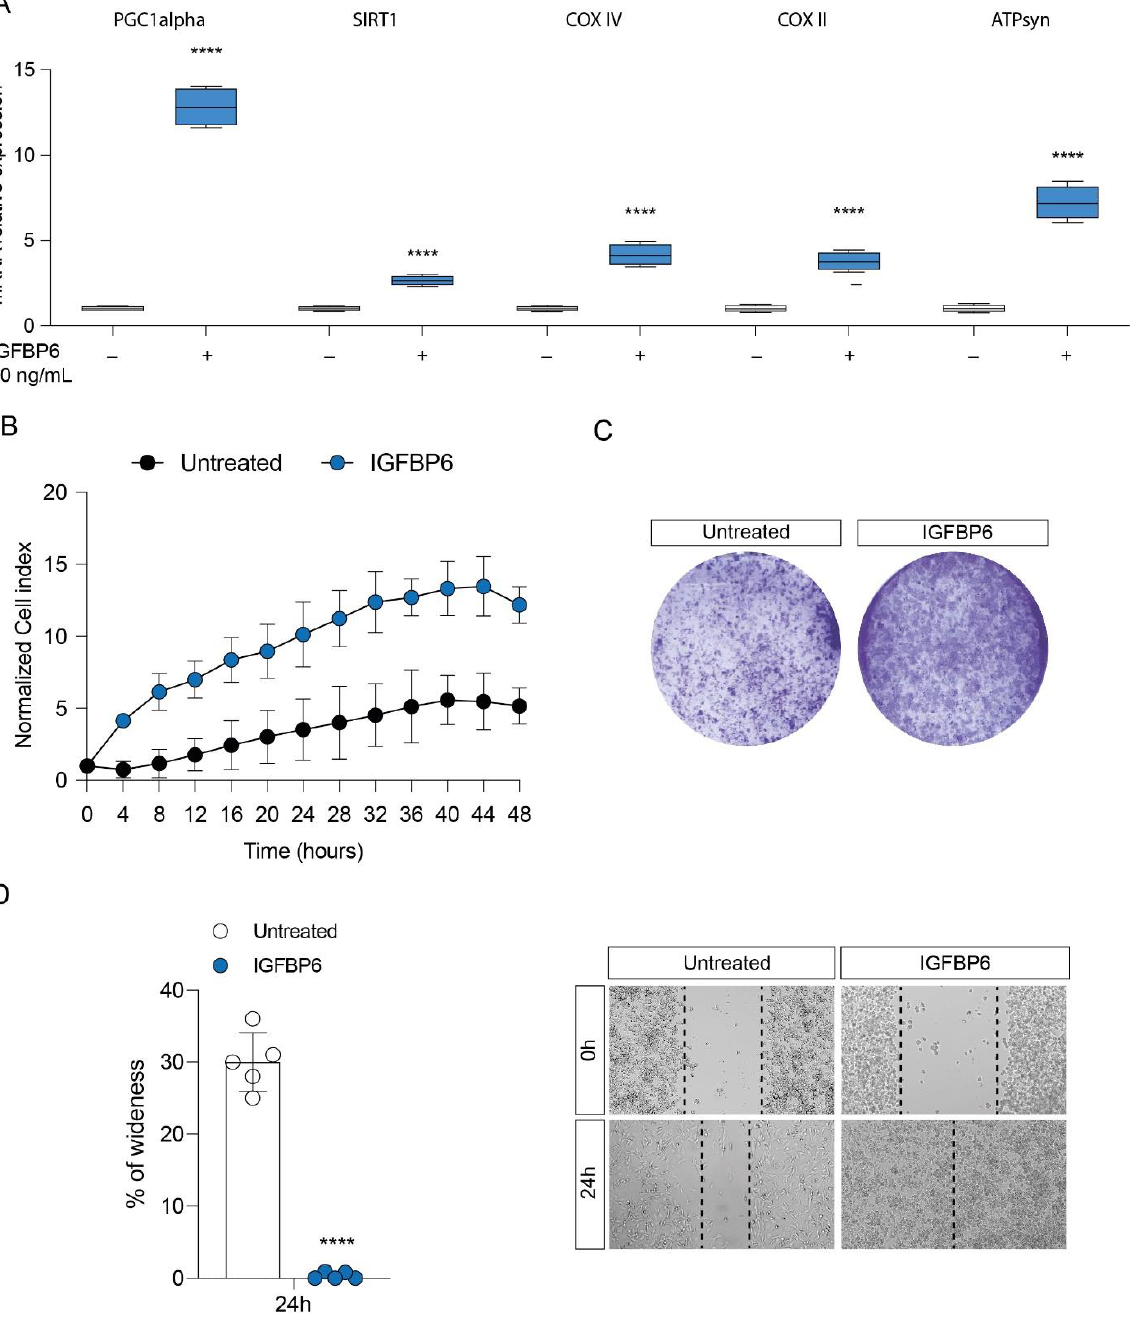
Figure 4. IGFBP6 modulates mitochondrial metabolism and promotes breast cancer cell proliferation. Evaluation of relative mRNA expression levels of PGC1 alpha, SIRT1, COX IV, COX II and ATPsyn ( A ), following 24 h of IGFBP6 (400 ng/mL) treatment. The calculated value of 2 - ΔΔCt in untreated controls is 1. Effect of IGFBP6 exposure (800 ng/mL) on cell proliferation ( B ), colony formation capacity ( C ) and wound healing ( D ). Data are expressed as mean ± SD of at least four independent experiments. **** p < 0.0001.